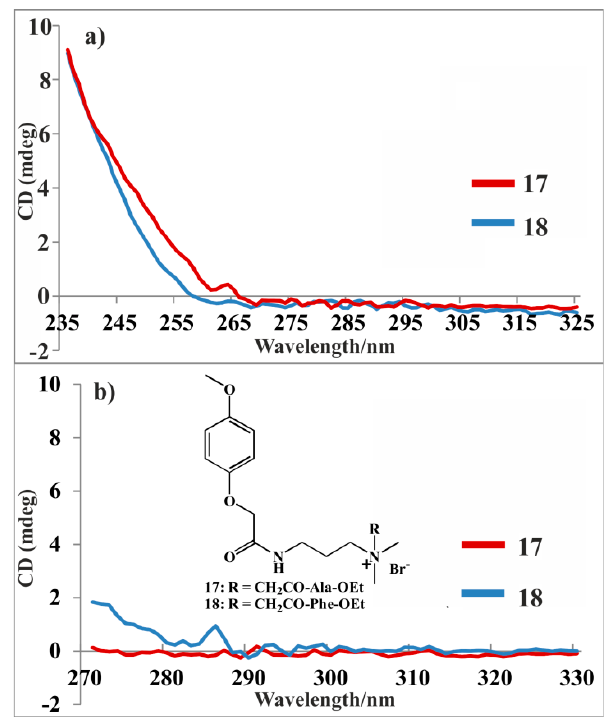
Figure 3. ( a ) CD spectra of compounds 17 (red) and 18 (blue) in water (5 × 10 − 4 M); ( b ) CD spectra of compounds 17 (red) and 18 (blue) in DMSO (5 × 10 − 4 M).